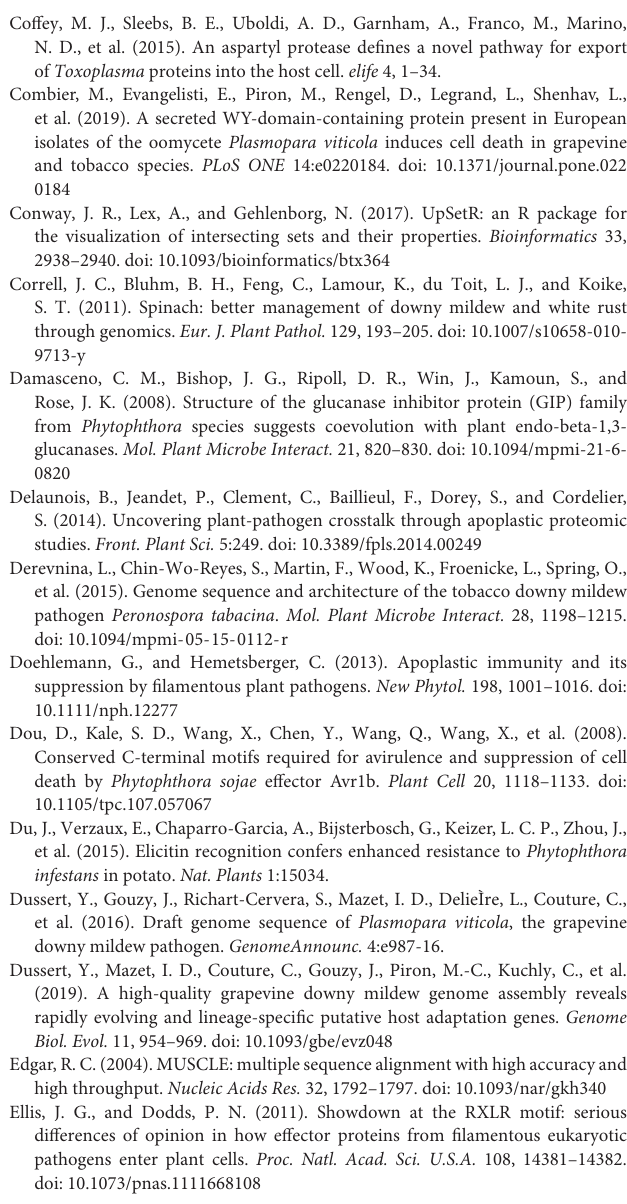
TABLE S8 | Predicted sub-cellular localizations of RXLR effectors in Pseudoperonospora humuli . Predictions were made using DeepLoc-1.0 (Almagro Armenteros et al., 2017).